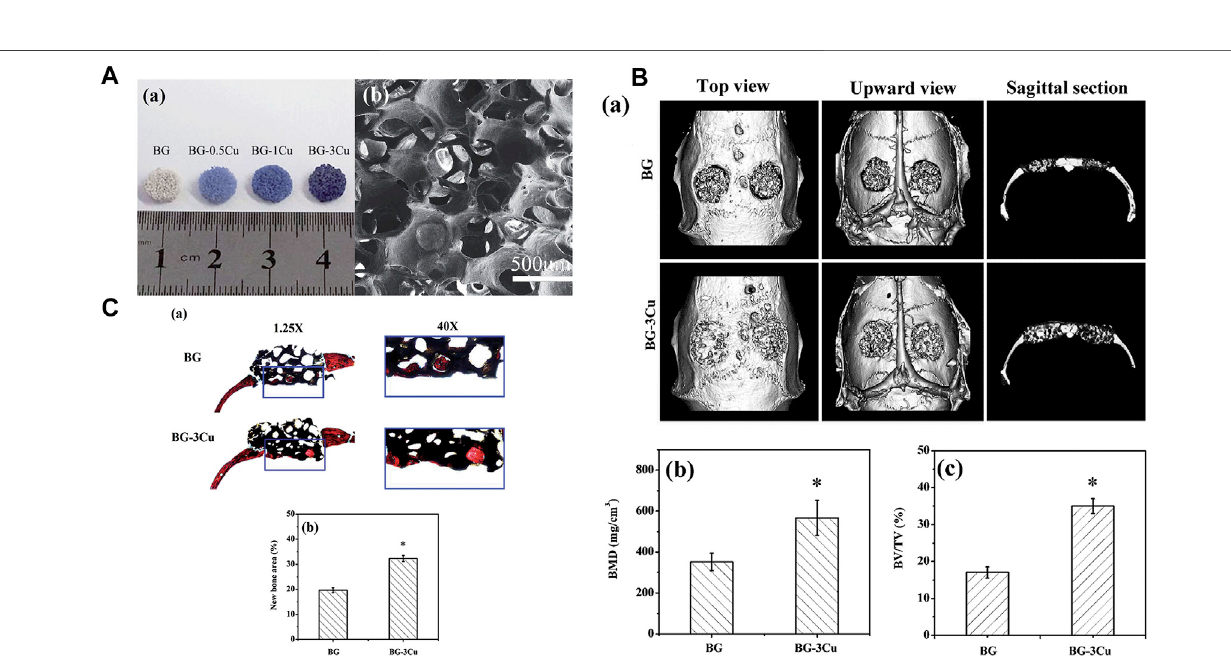
Frontiers in Bioengineering and Biotechnology |